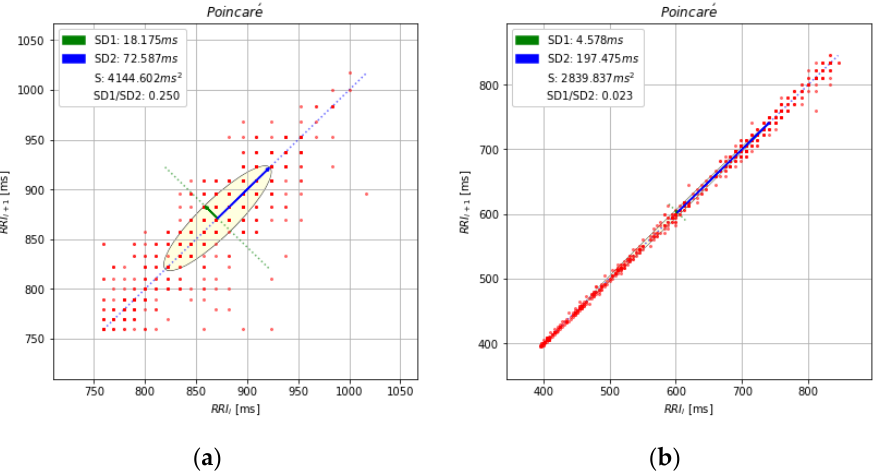
Figure 3. ( a ) Poincaré plot of RR time series from a healthy subject at rest; ( b ) Poincaré plot of the same time series as in Figure 1 (for more details see Appendix A.4).